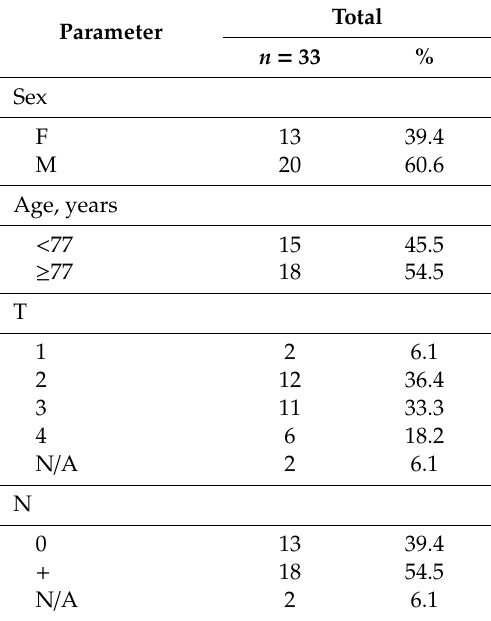
Table 1. Clinical pathological characteristics of patients. Tumor staging was done based on the